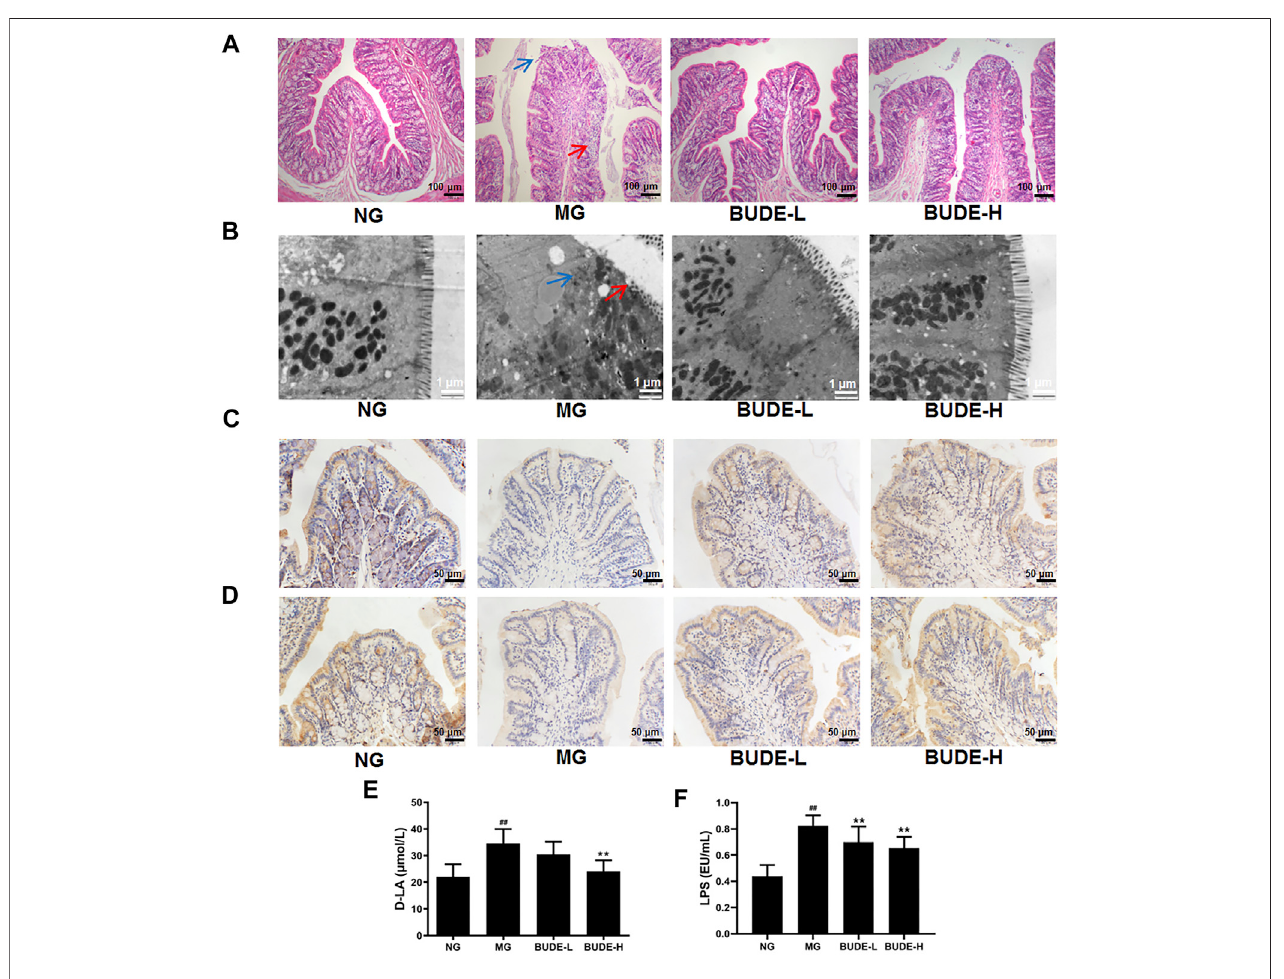
FIGURE8| EffectofBUDEonintestinalbarrier. (A) Representativegraph( × 200)ofhematoxylinandeosinstainingofthecolon:sheddingofcolonicvilli(bluearrow) andasmallamountofin fl ammatorycellin fi ltration(redarrow) (B) Colonultrastructurebytransmissionelectronmicroscopy(TEM)observedatmagni fi cation × 20000:Villi loss (red arrow) and tight junction protein damage (blue arrow). (C) Representative fi gures of immunohistochemical staining of claudin-1 in the colon ( × 200). (D) Representative charts of immunohistochemical staining of occludin in the colon ( × 200). (E) Changes in the plasma D -lactic acid (D-LA). (F) Changes in the plasma lipopolysaccharide (LPS). Compared with the normal control group # p < 0.05, ## p < 0.01; compared with the model control group * p < 0.05, ** p < 0.01, n (cid:2) 3,